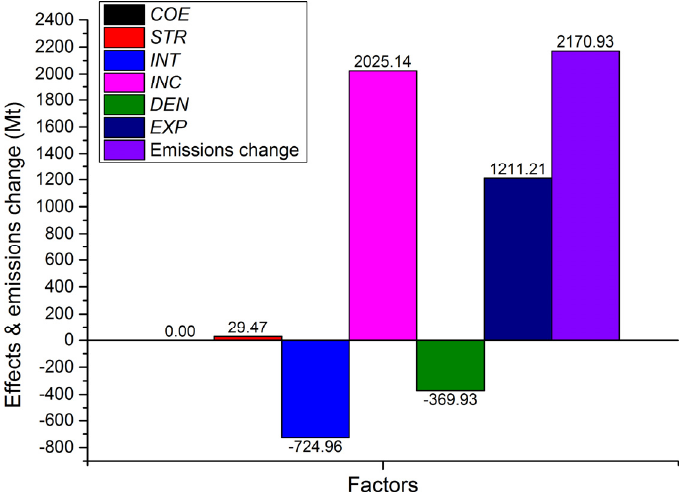
Figure 4. Effects of the factors on carbon emissions in China from 2001 to